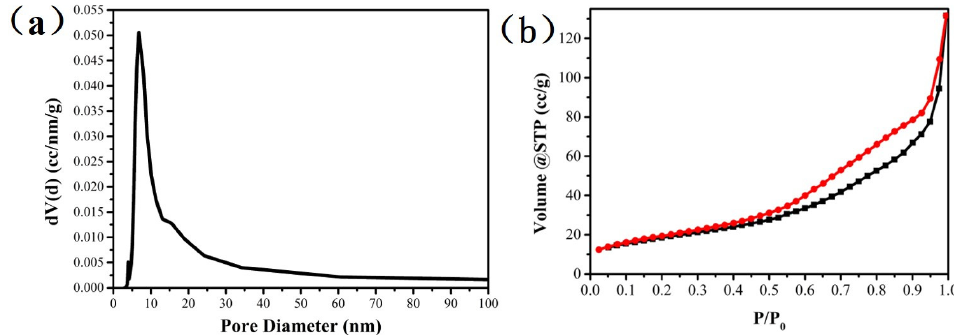
Figure 3. Pore size distribution ( a ) and N 2 hysteresis curve ( b ) of non-stacked γ -Fe 2 O 3 /C@TiO 2 .